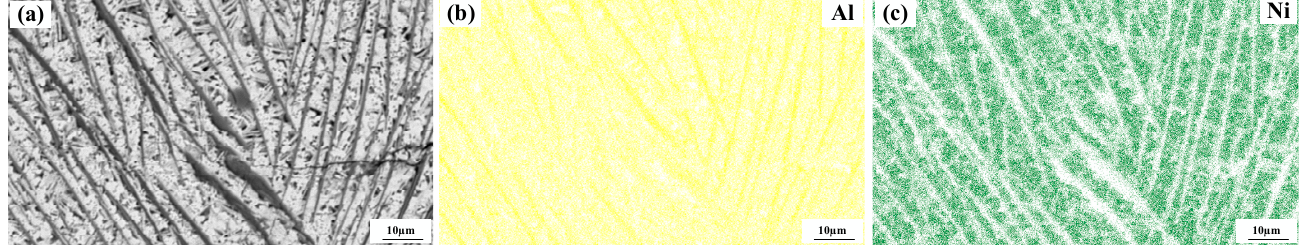
Figure 6. Composition analyses of surface scanning for specimen 3 (1% graphene content): ( a ) SEM image; ( b ) Al; ( c ) Ni.